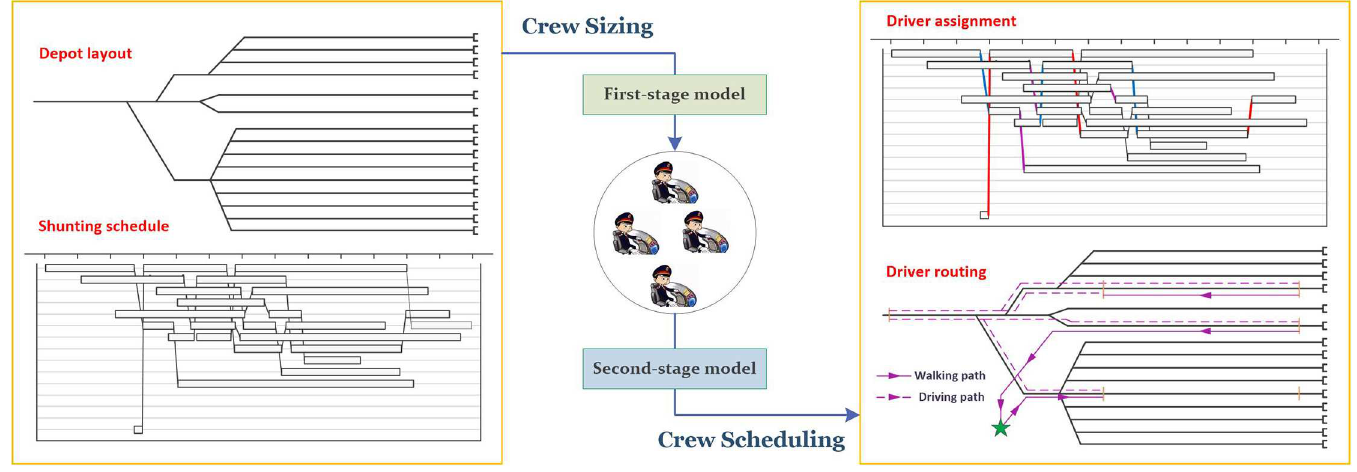
Fig 1. The two-stage optimization framework. normal constraint method, and optimize it with a modified Pareto filter algorithm. Section